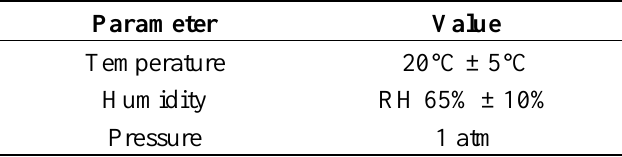
Table 2. Experimental environment.